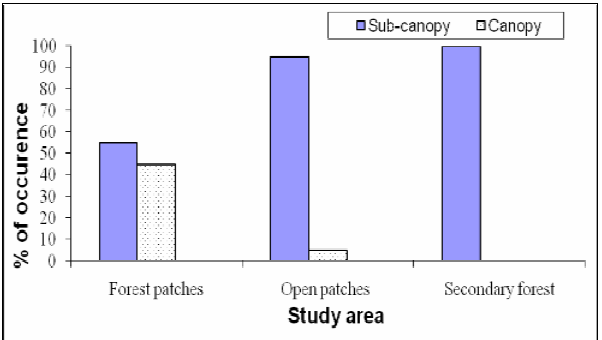
Fig. 1. Distribution of epiphytes into canopy, sub-canopy